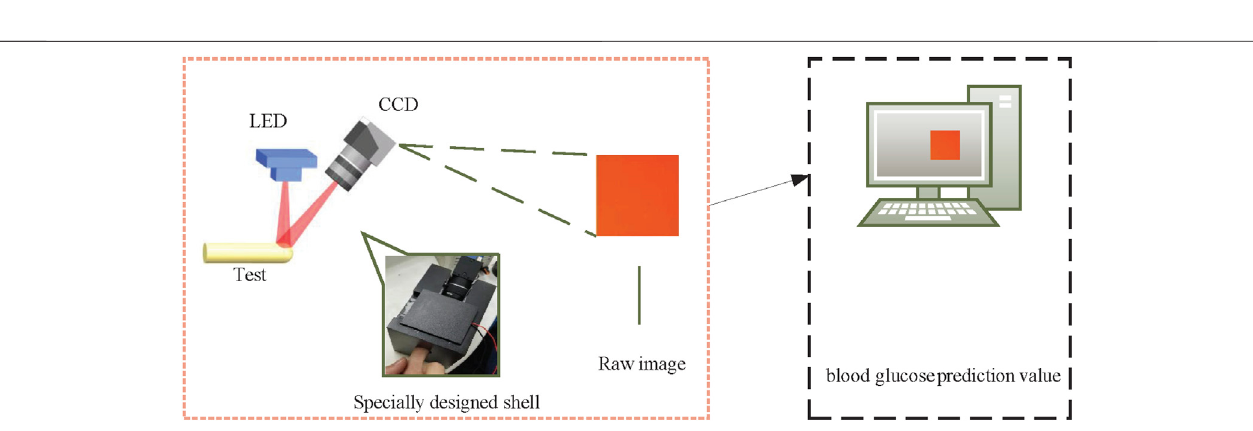
Frontiers in Physics |